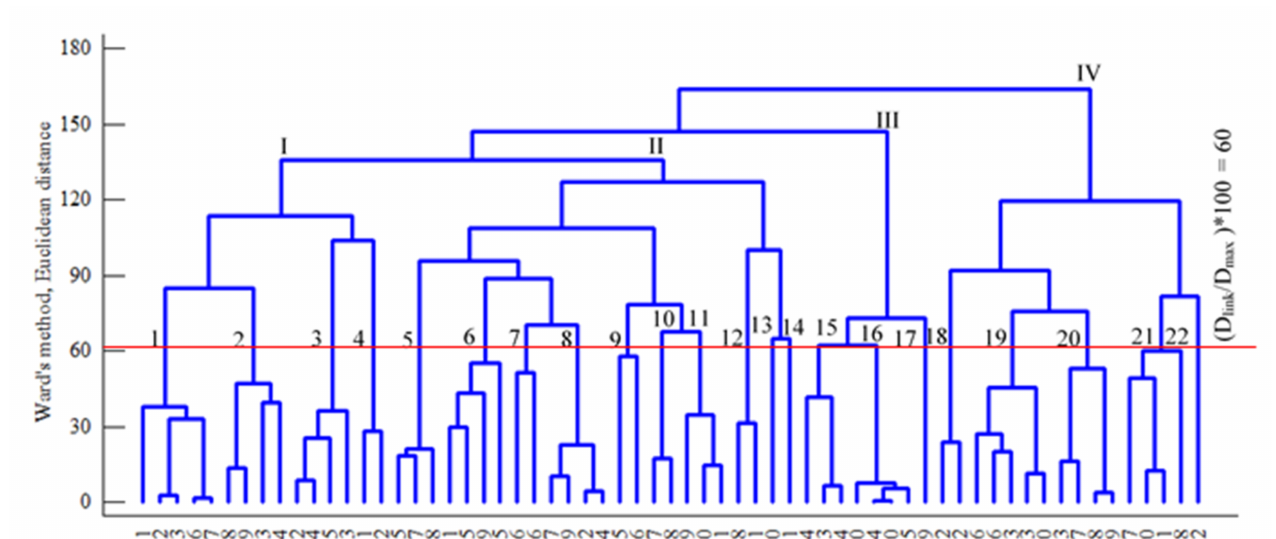
Figure 4. Clustering surface water quality in the water bodies in Vinh Long